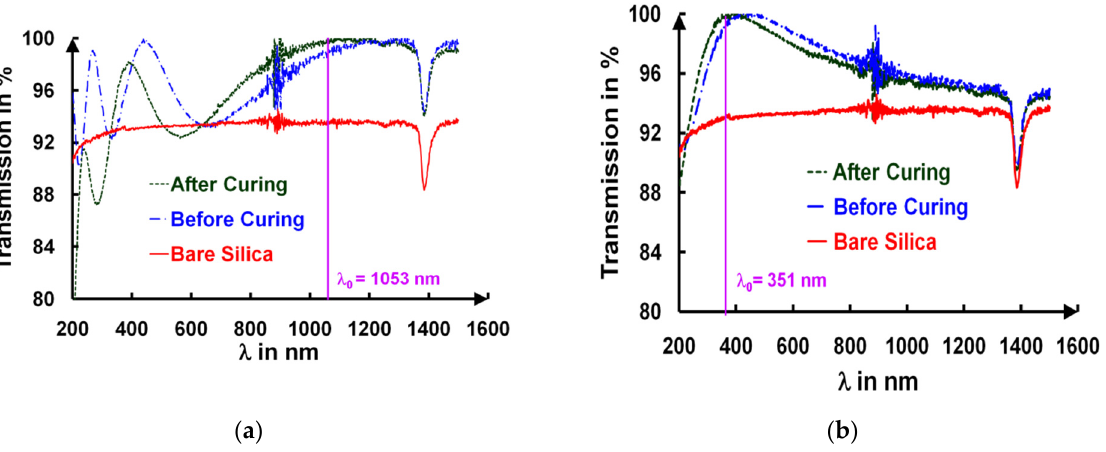
Figure 6 . Spectral evolution of UV/visible of an AR 1  coating ( a ) and an AR 3  coating ( b ) before Figure 6. Spectral evolution of UV/visible of an AR 1 ω coating ( a ) and an AR 3 ω coating ( b ) before and after 17 h of curing. and after 17 h of